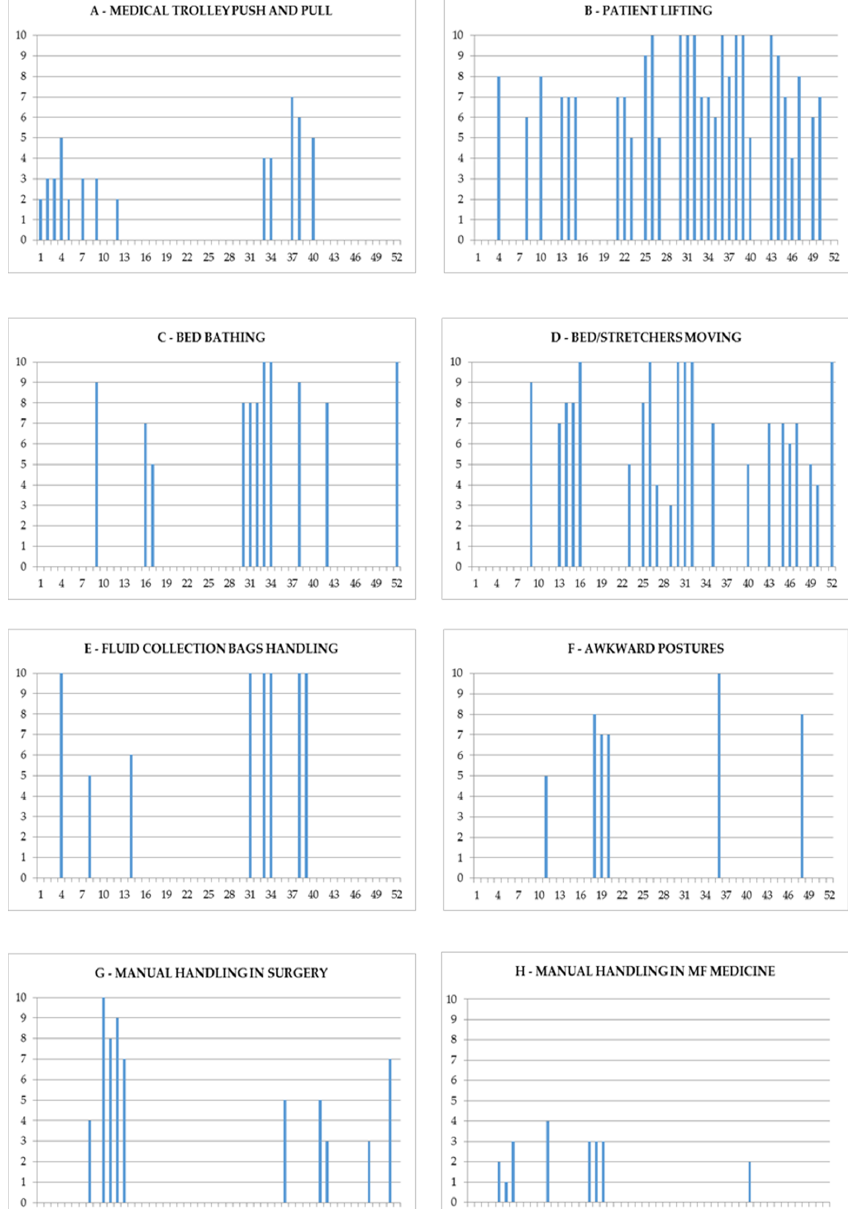
Figure 3. Answers provided by healthcare workers (HCWs) to the questionnaire. A–H each box refers to a task identified by the HCWs as overloading. The abscissa axis shows the reference number of the HCW. The ordinate axis shows the value of the Borg scale (Borg CR-10) attributed by each worker to the